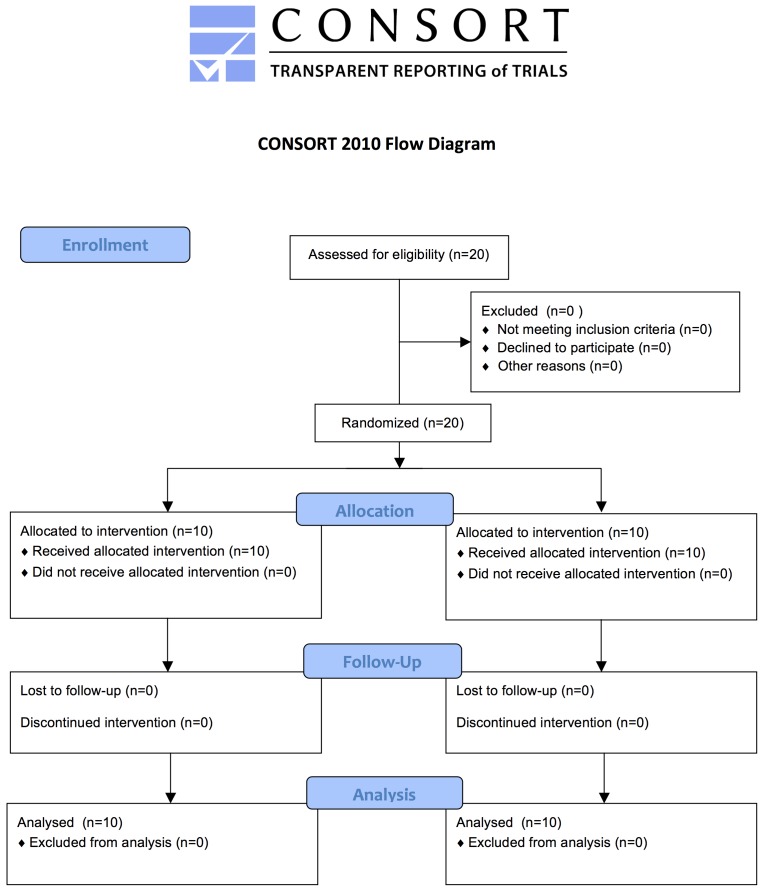
CONSORT Flow Diagram.